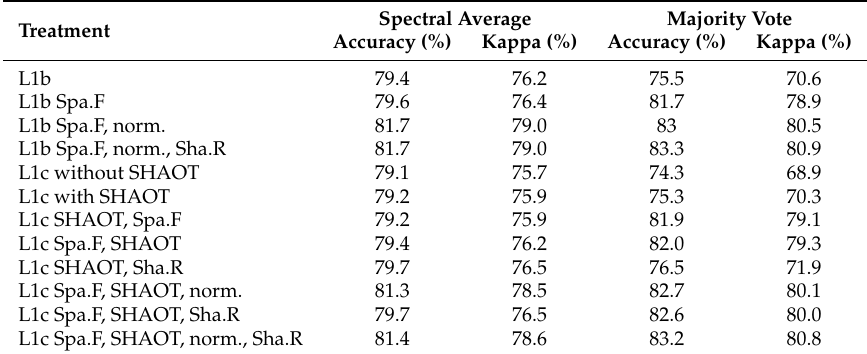
Table A1. Summary of mean accuracies and kappa results from data acquired on the 19 September using the 20 most abundant species and comparing two strategies: object and majority vote.